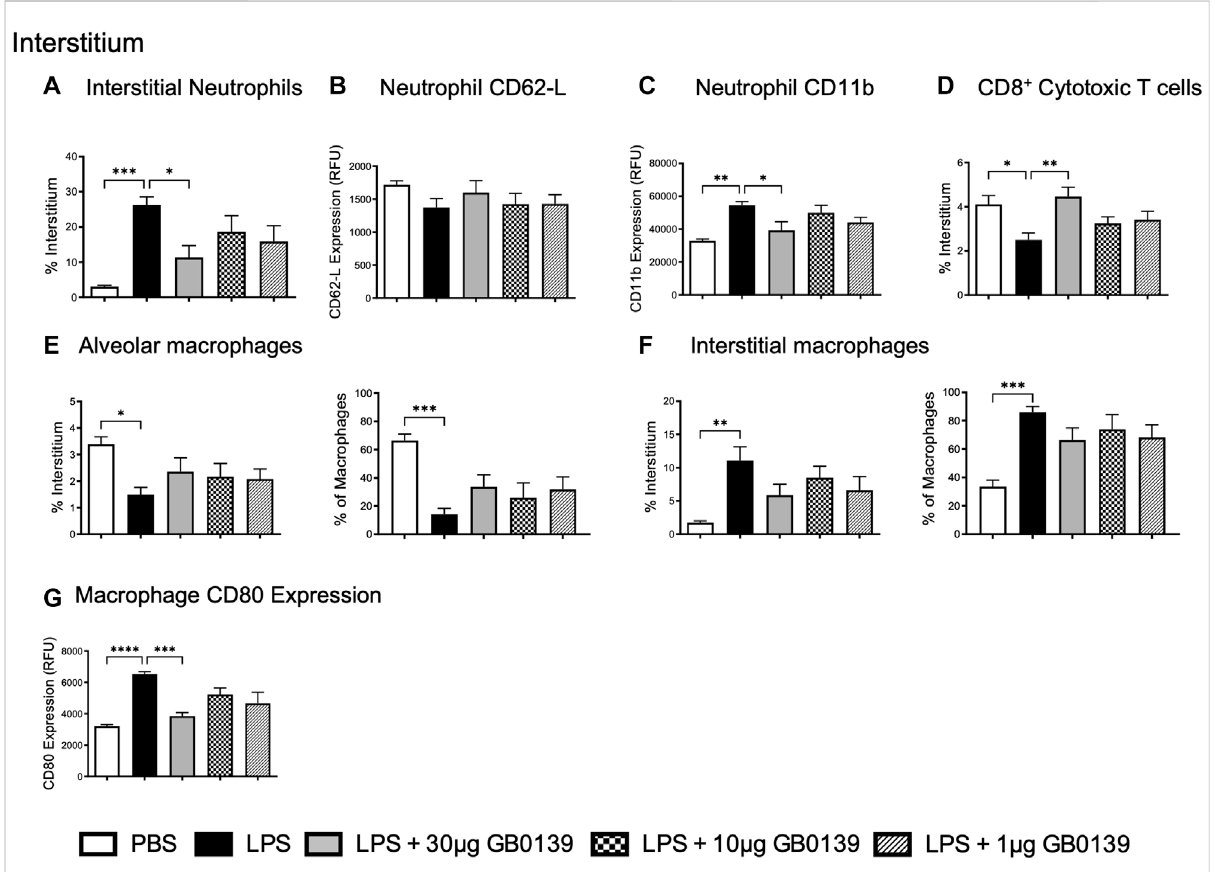
FIGURE 3 Flow cytometric analysis of whole lung digests following LPS-induced lung in fl ammation. 10 µg LPS was administered alongside 1, 10 or 30 μ g GB0139 i.t. and tissue retrieved 24 h later. (A – C) Interstitial neutrophil numbers and activation parameters (CD62L and CD11b). (D) Interstitial CD8 + cytotoxic T-cell accumulation. (E – F) Alveolar and interstitial macrophage accumulation, and (G) CD80 expression. Data represented as mean ± SEM. Analysed via 1-way ANOVA (n = 6, * p < 0.05, ** p < 0.01, *** p < 0.001, **** p < 0.0001). ANOVA = analysis of variance; h = hours; i.t. = intra-tracheal; LPS = lipopolysaccharide; RFU = relative fl uorescence units; SEM = standard error of the